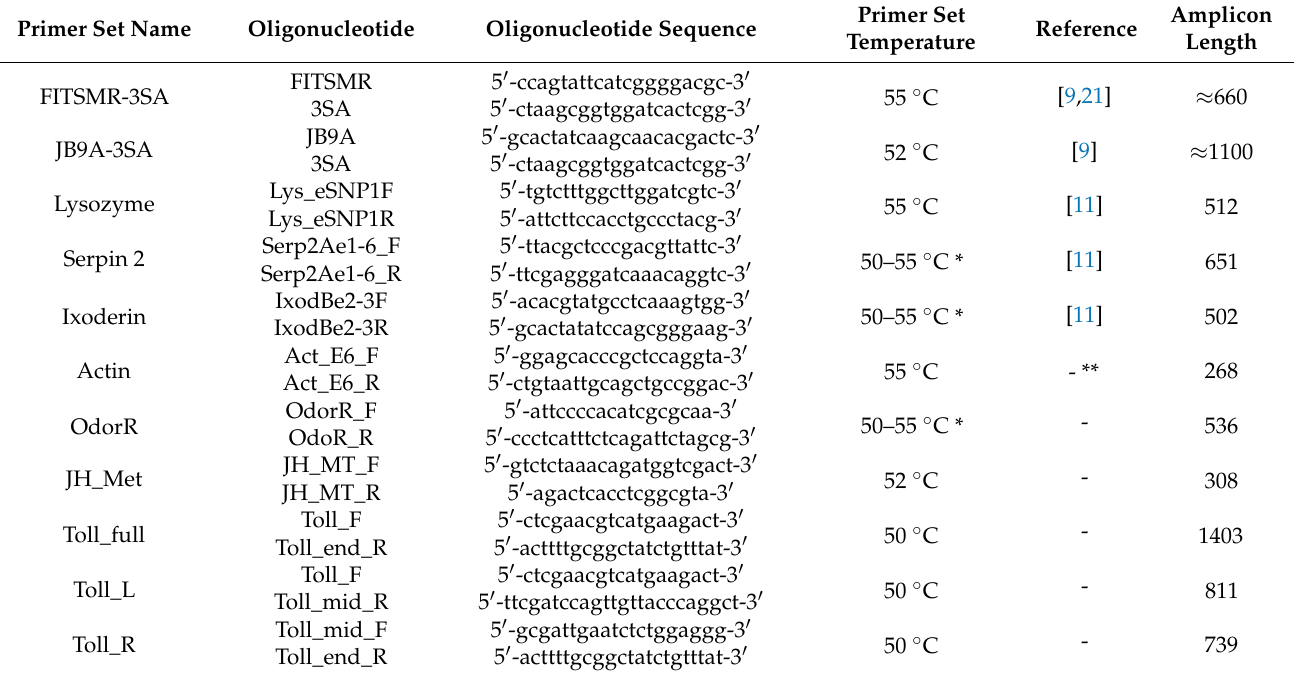
Table 2. Primer sets used in this